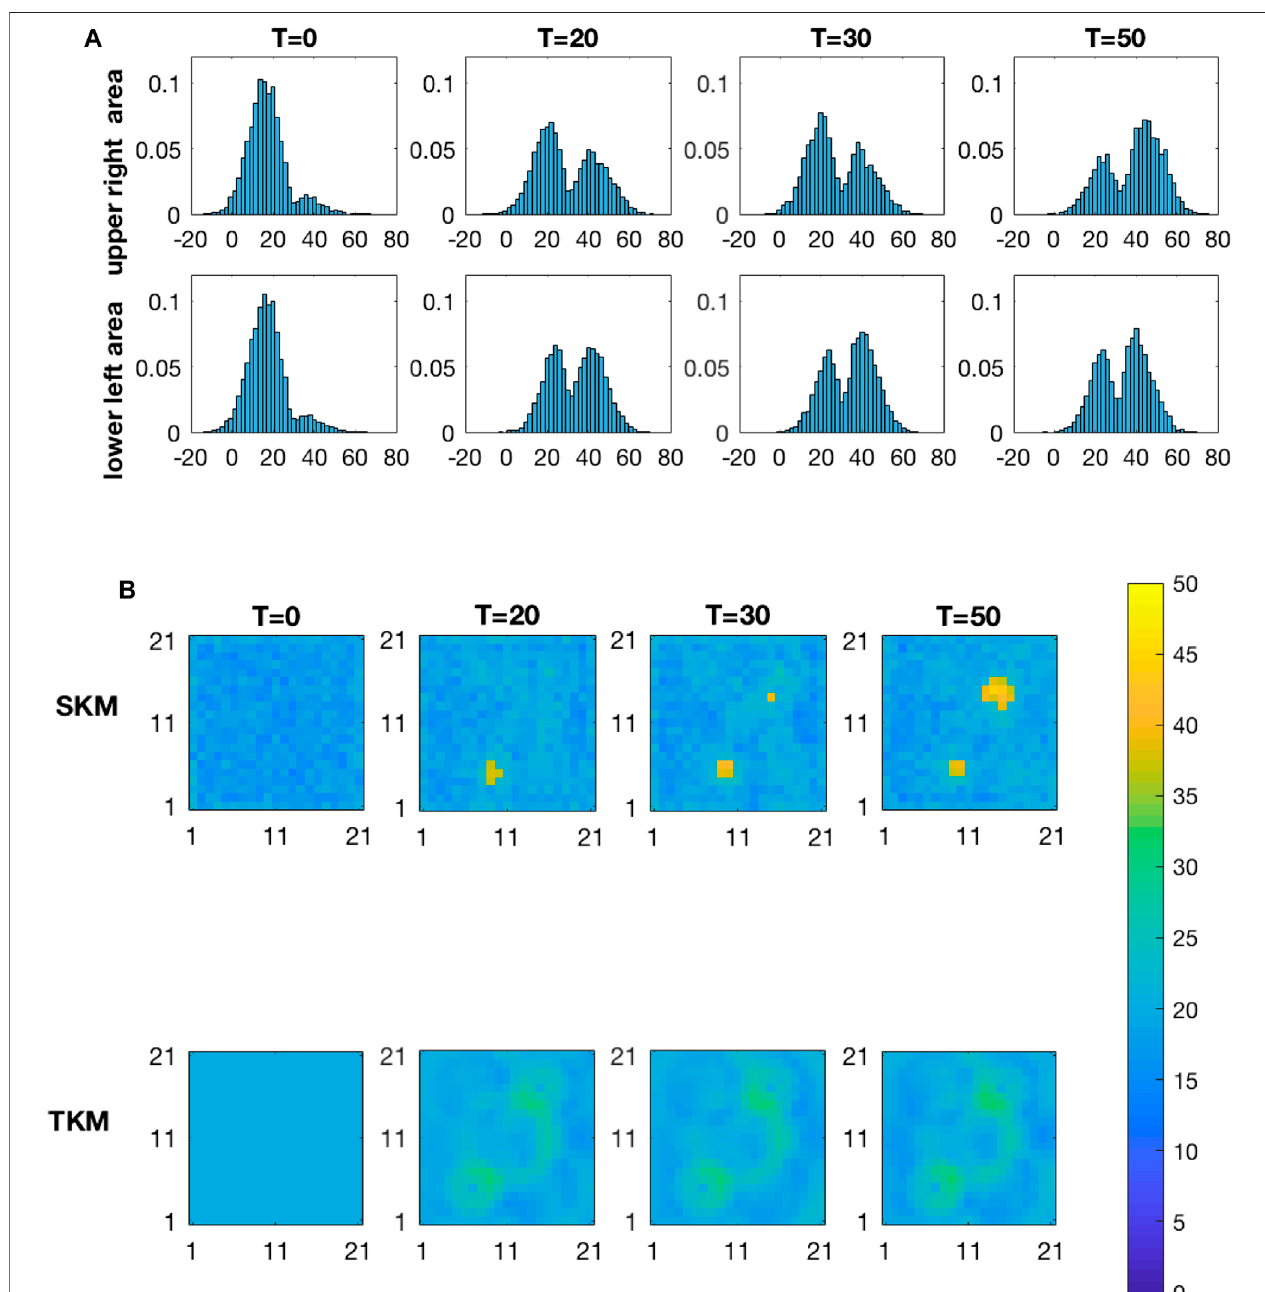
FIGURE 14 | Results from the two-yellow-area test